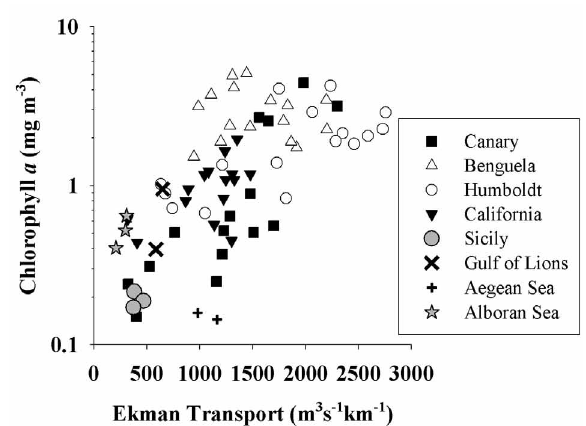
Fig . 5. – Relationship between climatological mean offshore Ekman transport and Chl a concentration (in logarithmic scale). Mediter- ranean sites’ data values are given in Table 1. Data on Canary, Benguela, Humboldt, and California EBUS regions from Patti et al . (2008).